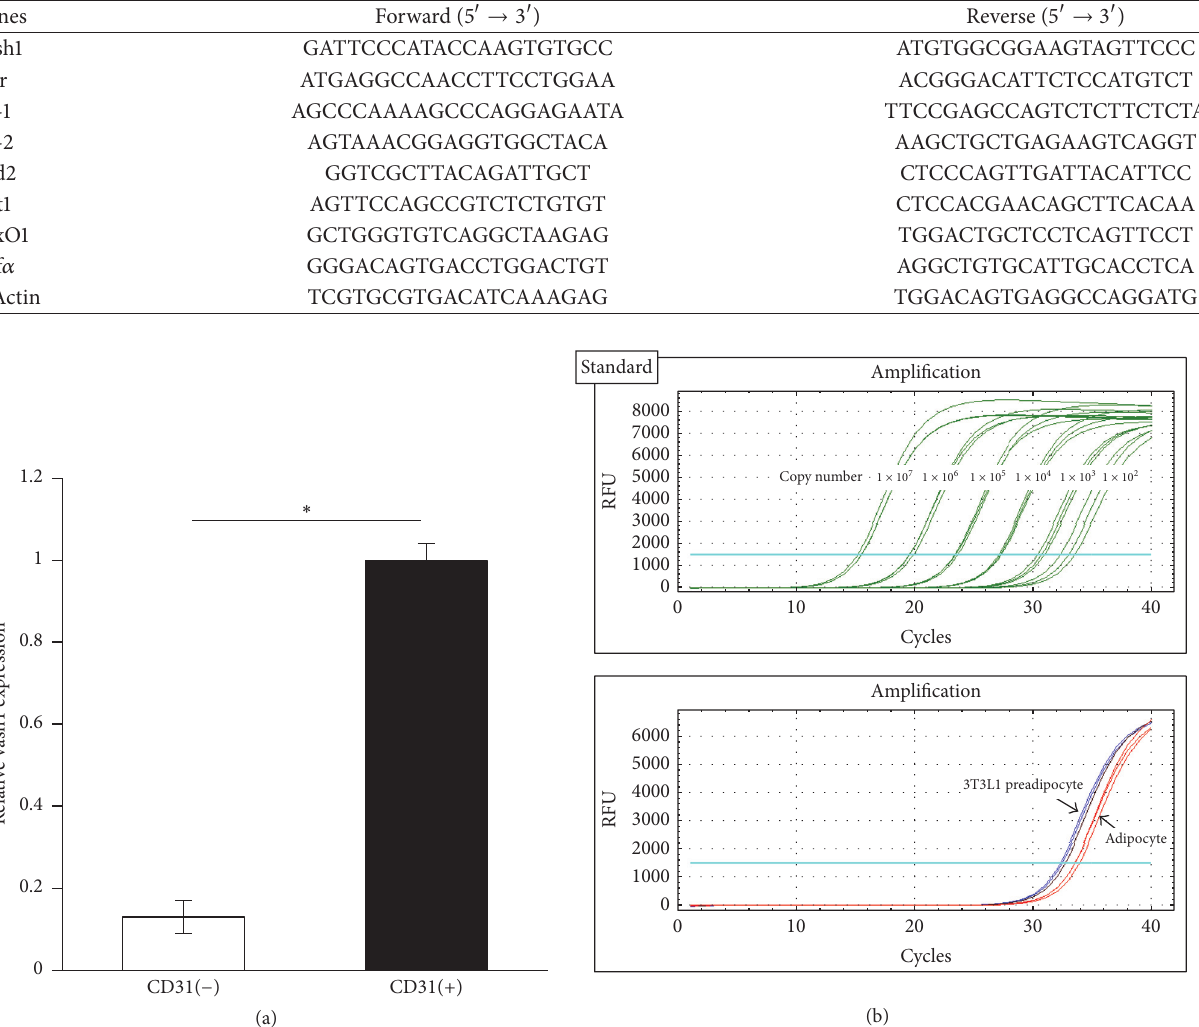
Figure 5: Vash1 is expressed in ECs but not in adipocytes. (a) CD31-positive and -negative cells from the WAT of young WT male mice were separated as described in Materials and Methods, and the expression of vash1 was compared. Means ± SDs are shown. The statistical significance of differences was calculated by use of the unpaired Student’s 𝑡 -test, and a value of 𝑝 < 0.05 was the criterion for significance. (b) 3T3L1 preadipocytes were caused to differentiate into adipocyte in vitro, and the expression of vash1 in those cells was quantified as described in Materials and Methods. ∗ 𝑝 < 0.05